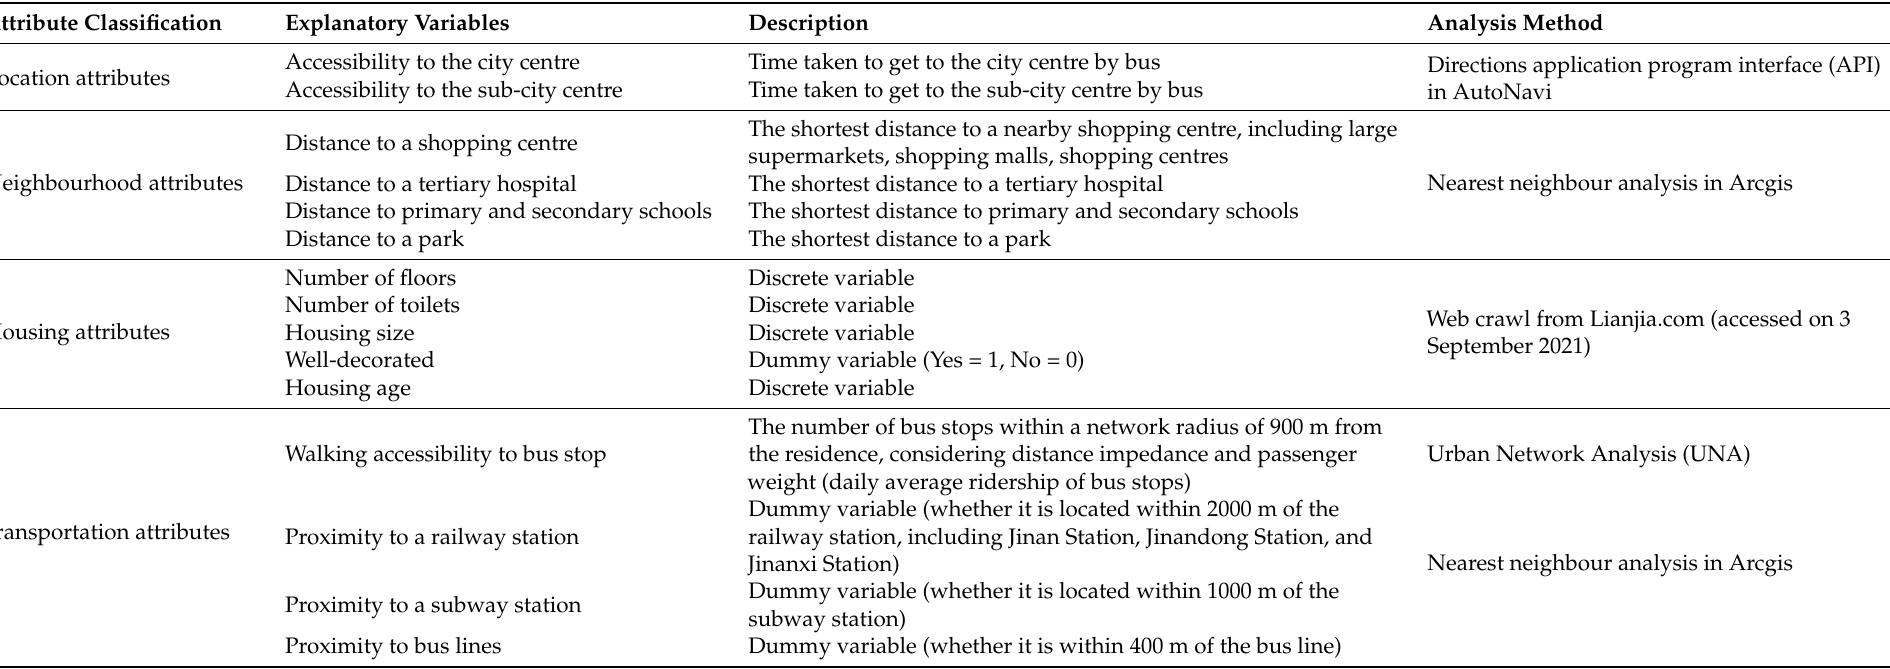
Table 1. Indicator system of influencing factors of residential